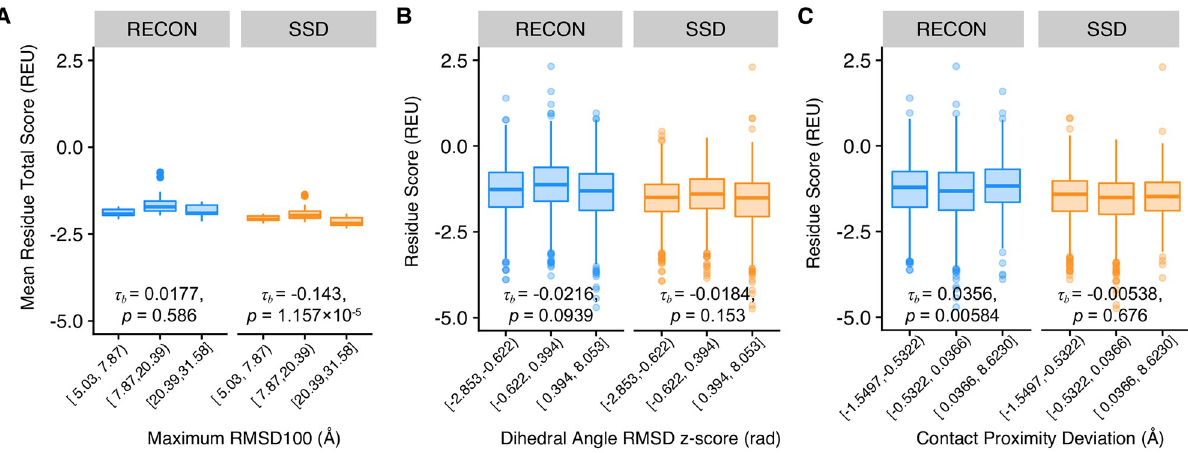
Fig 9. Comparison of conformational diversity and per-residue total scores. All panels are binned into low, medium, and high x values, with equal number of data points for each bin. A Kendall τ β rank correlation test was performed on each profile to measure the strength of dependence of native sequence recovery on the x axis value, indicated in each plot along with its associated p -value. (A) Comparison of maximum RMSD100 and mean total energy score, normalized by the number of residues. (B) Comparison of normalized RMSD da z -score and mean total energy score of each residue. (C) Comparison of normalized contact proximity deviation z -score and mean total energy score of each